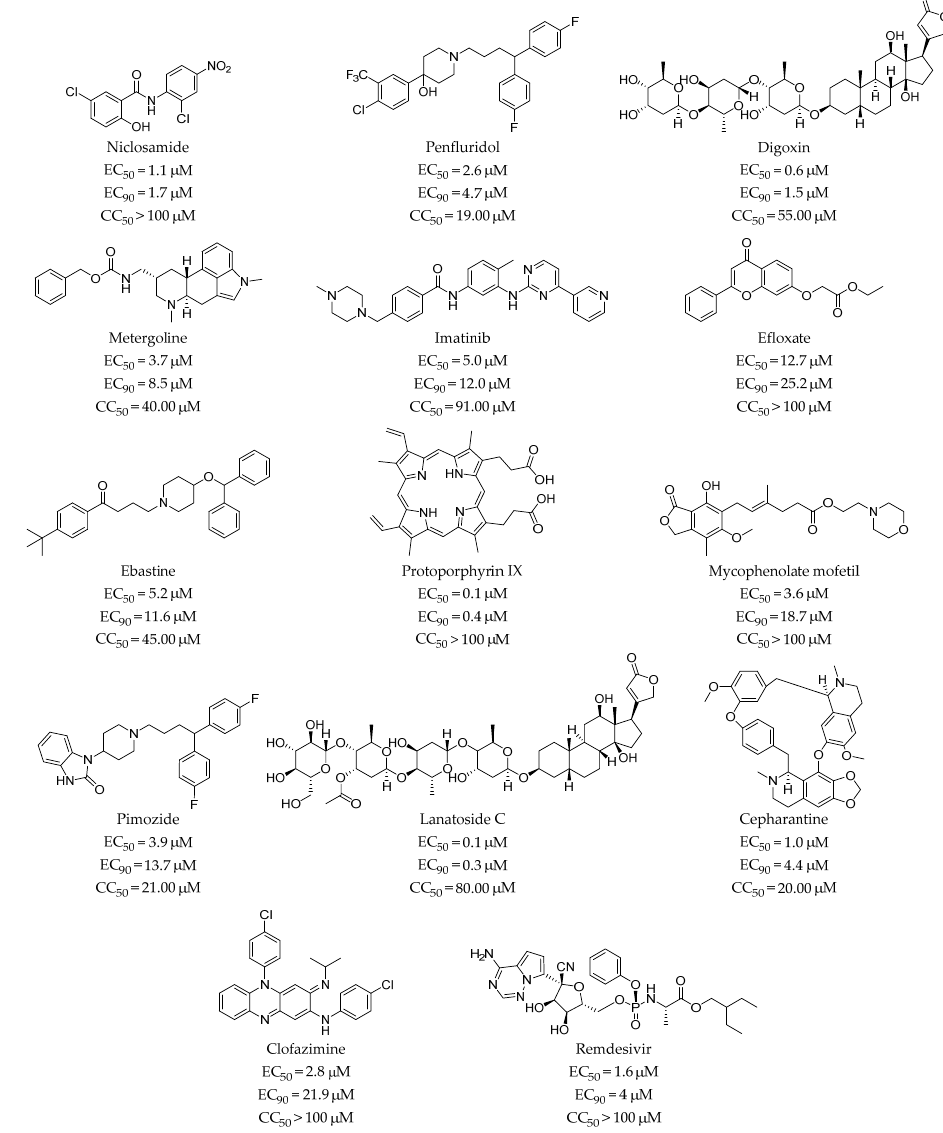
Figure 3. Potency and cytotoxicity indexes of the confirmed primary hits. Potency (EC 50 ; EC 90 ) and cytotoxicity (CC 50 ) were calculated from dose-response experiments in which infection efficiency was determined by viral antigen accumulation and MTT activity respectively (see Figures S2 and S3 of the Supplementary Materials). Remdesivir was included as control of the assays.